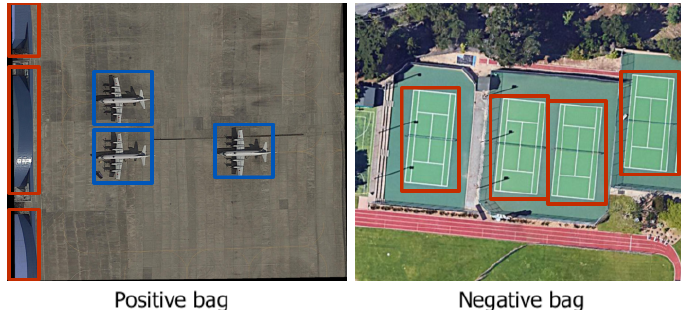
Figure 6. An example of positive/negative bags for the “airplane” class. Bounding boxes correspond to the proposals input to the network; blue indicates positive instances, while red indicates negative instances. MIL-based WSOD aims to differentiate between positive and negative instances based only on image-level